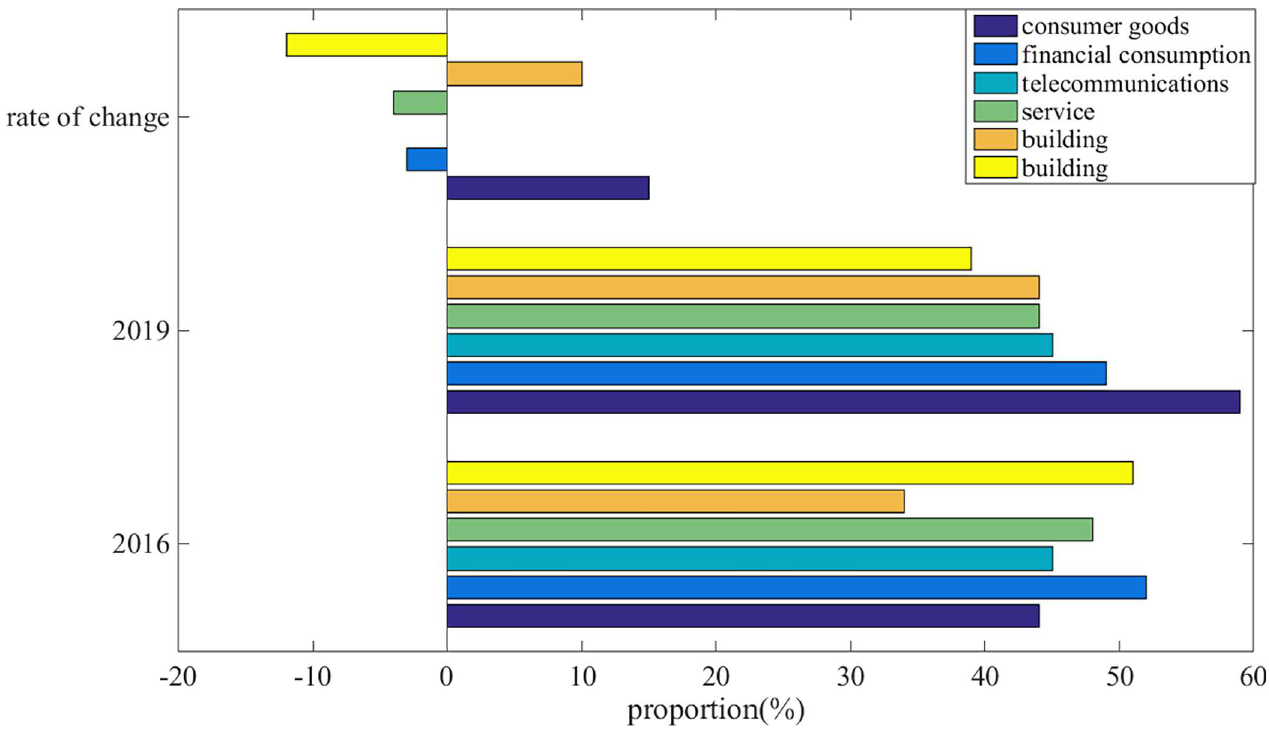
Fig 7. Comparison of the number of fraud cases in various industries